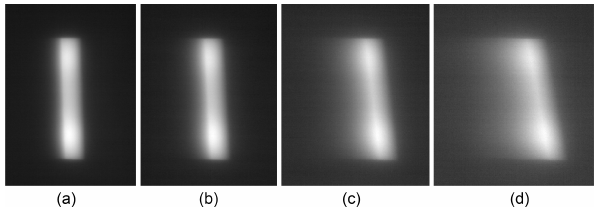
Figure 2. Microbolometer images of a small plate moving from the left to the right with different speed: 0.3 (a) , 0.5 (b) , 1 (c) and 1.5ms − 1 (d)